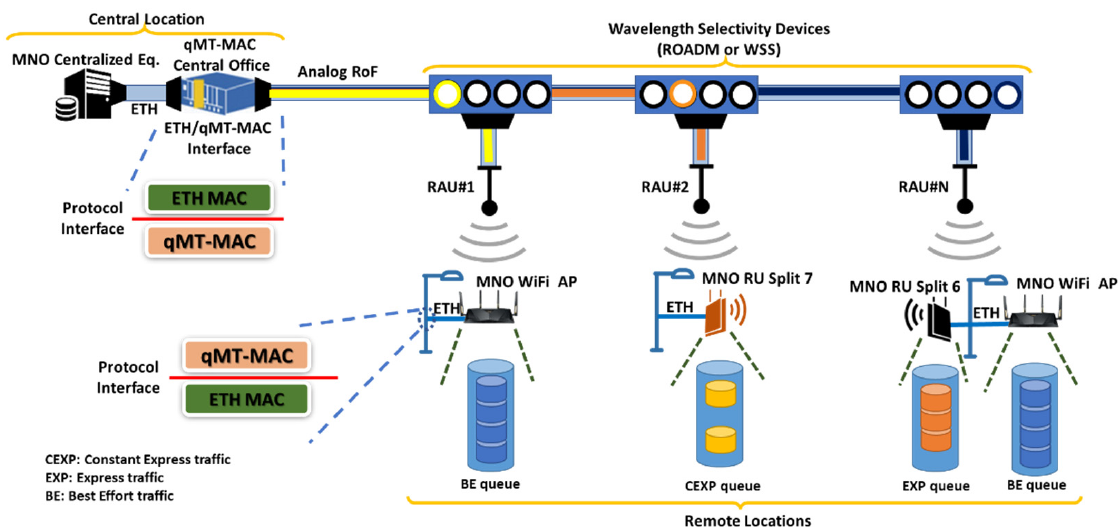
Figure 1. System model depicting the Point-to-Multipoint topology of the qMT-MAC A-RoF transport network: the MNO centralized equipment is connected to the qMT-MAC Central Office, while the MNO remote equipment is connected to the qMT-MAC nodes.